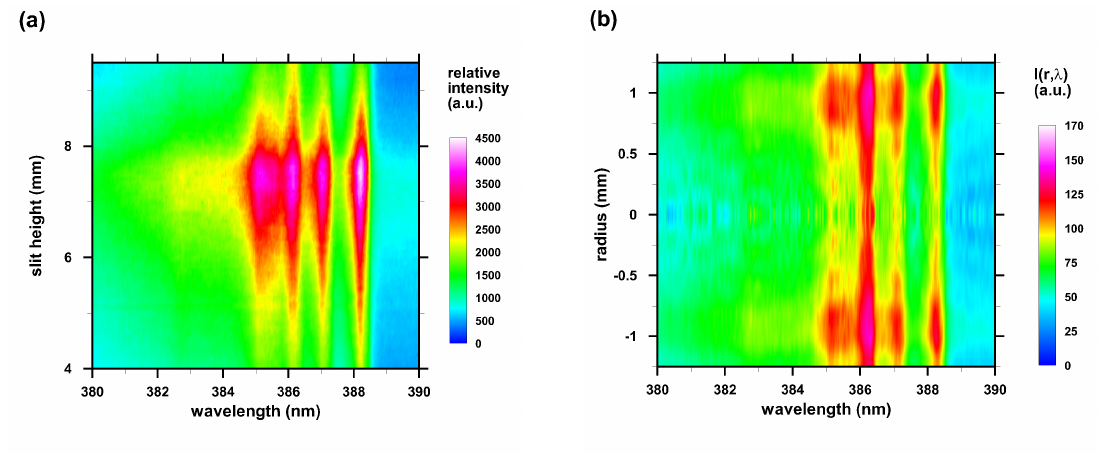
Figure 13. Diatomic molecular spectra: time delay 700 ns, gate width 125 ns. ( a ) Line-of-sight contour map of measured spectra. ( b ) Abel inverted spectra versus radius. Near 1 mm, the CN ∆ v = 0 sequence shows 0-0, 1-1, 2-2, 3-3 and 4-4 band heads, and the second order, 193.08-nm atomic carbon line masks the 2-2 band. The CN signals are smaller near center. The carbon line appears narrower at the center than at the 1-mm radial position, indicating lower electron density at